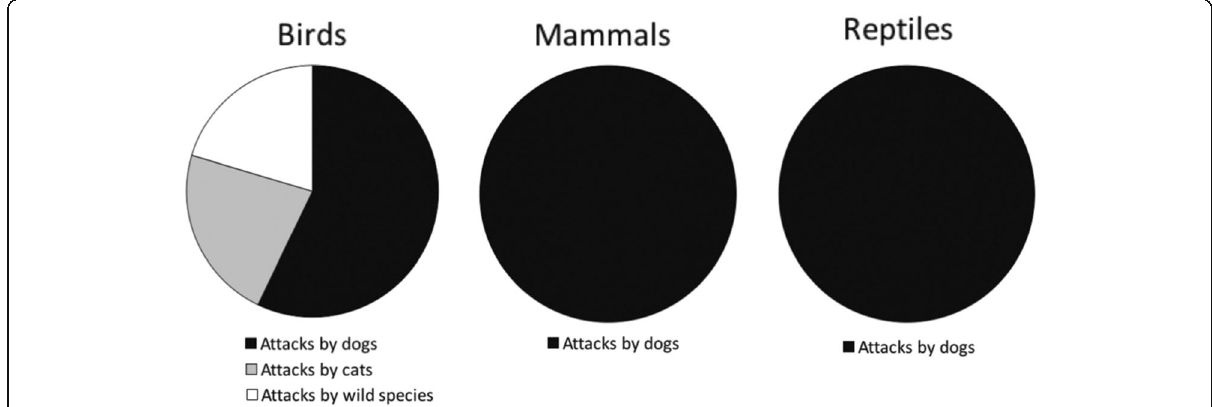
Fig. 4 Specific causes of animal interaction cases in the different taxonomic groups at studied WRRC (2011 –